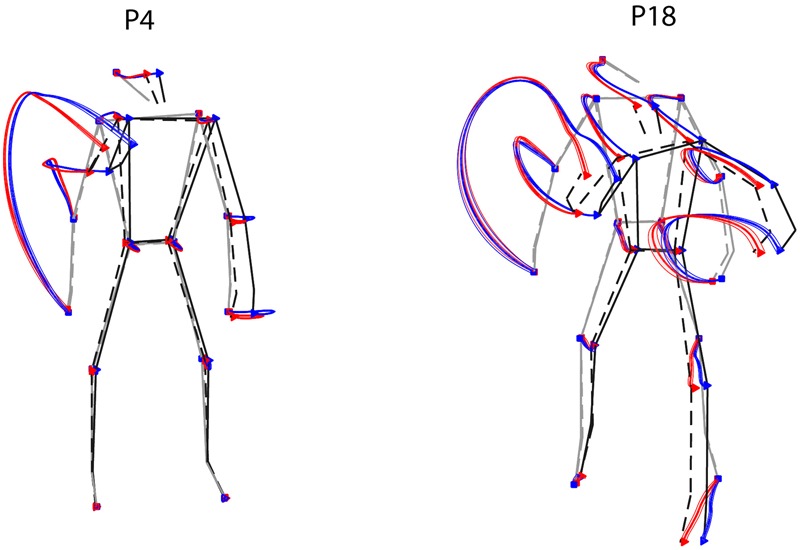
Examples of average kinematics by ball landing side. Average trajectories (thick solid lines), and corresponding standard errors (shaded areas), for throws to the right (red) and to the left (blue) are shown for two representative participants. The stick diagrams depict the average initial and final postures (gray and black respectively), for the right and left throws (dashed and solid respectively).